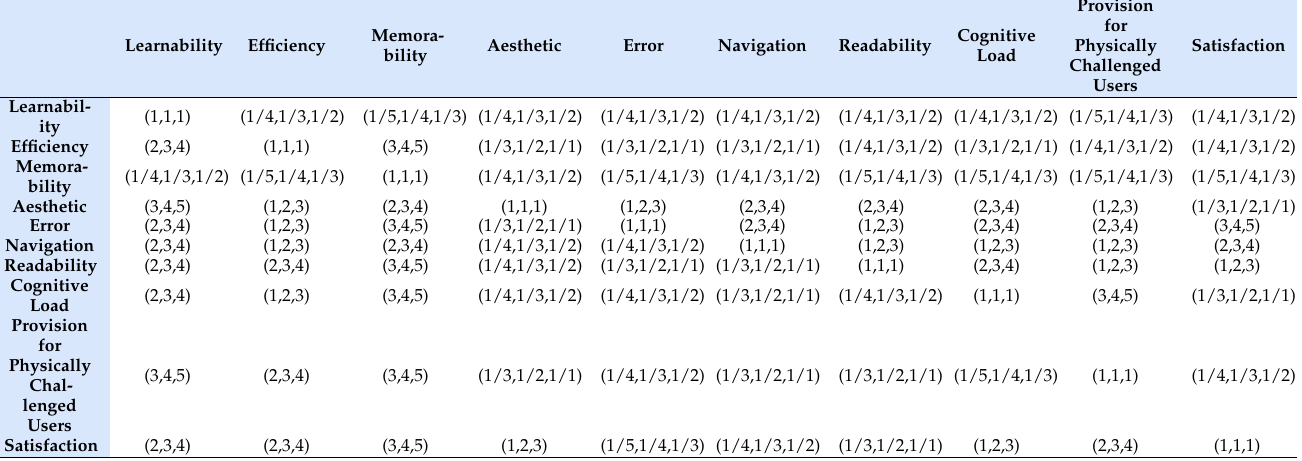
Table 4. Fuzzy pairwise decision matrices for